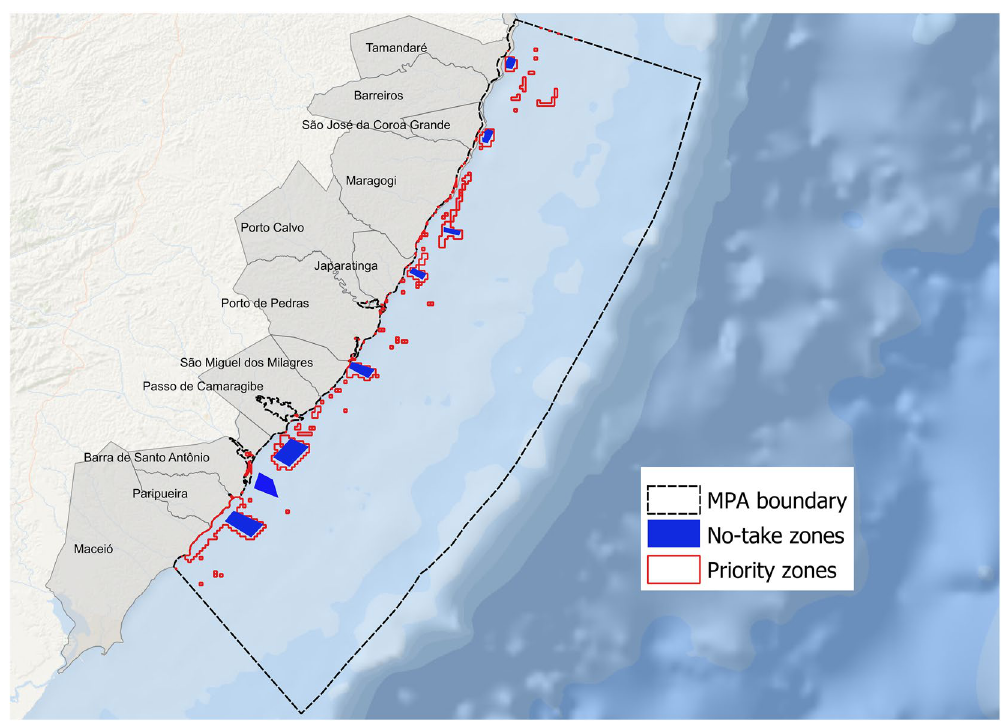
Figure 4. Priority zones identified using a systematic approach and existing no-take zones where fishing is currently not allowed within the MPA boundary. Figure elaborated by the authors using QGis